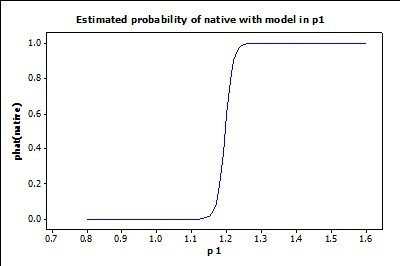
Graph of estimated probabilities for P1.